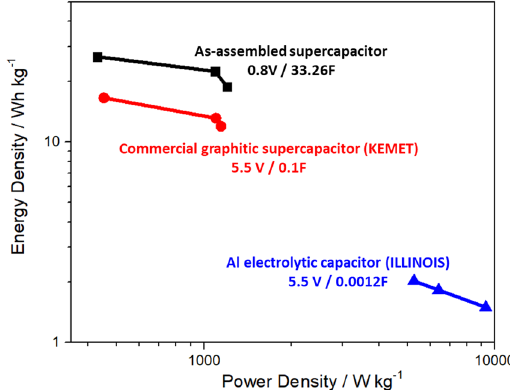
Figure 4. Ragone plots of as-assembled supercapacitor and commercial energy storage